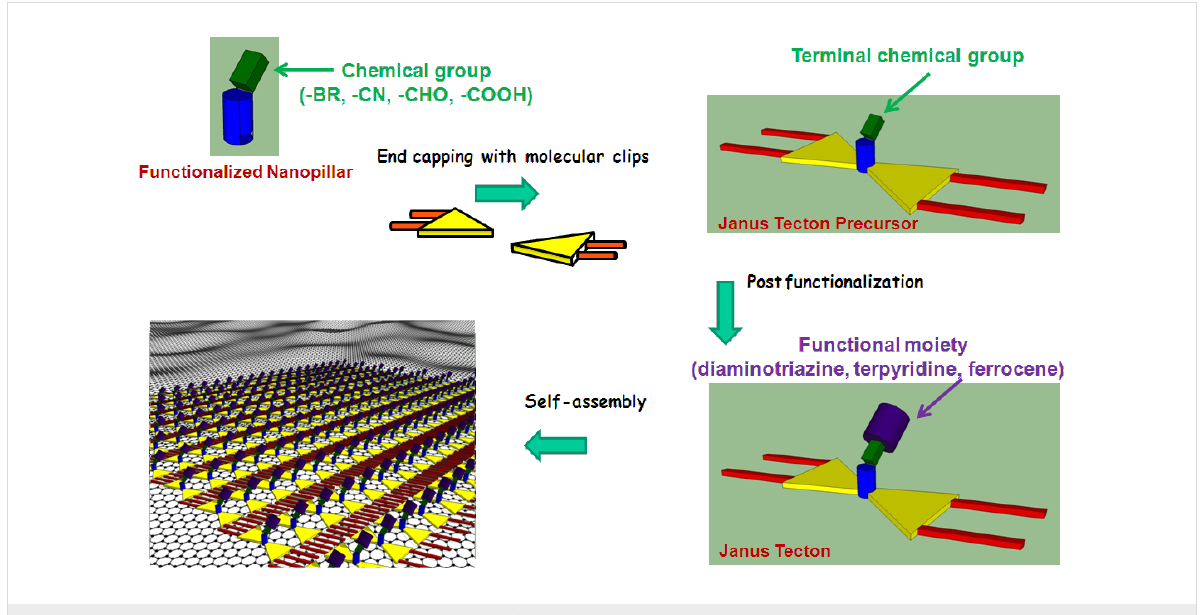
Figure 5: Synthetic strategy and expected organization on C(sp 2 )-carbon-based supports of the self-assembled Janus tectons, exposing a wide range of external interfacial compositions.